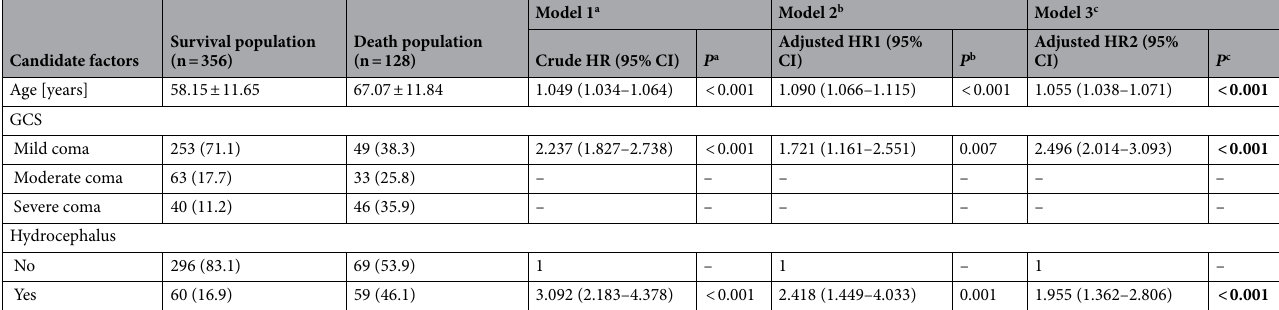
Table 1. Univariate and multivariate analysis of death-related factors in patients with cerebral hemorrhage in the training set. a Crude HR value and P value was calculated by univariate COX proportional hazard model. b HR value and P value was calculated by multivariate cox proportional hazard model, adjusted by all meaningful variables in univariate COX proportional hazard model. c HR value and P value was calculated by multivariate COX proportional hazard model, adjusted by age, GCS and hydrocephalus. Significant values are in